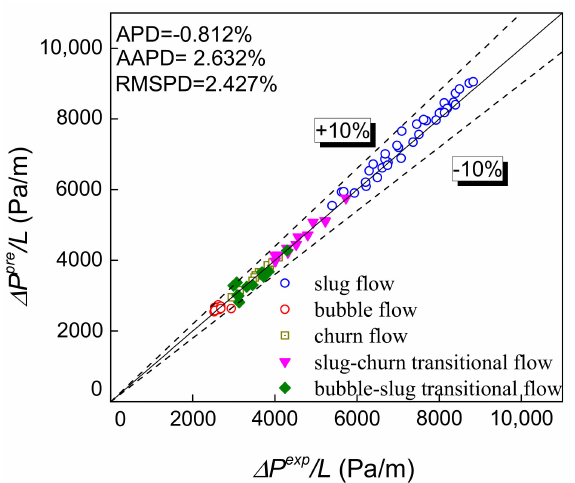
Figure 13. Comparison of pressure drop prediction and experimental results.